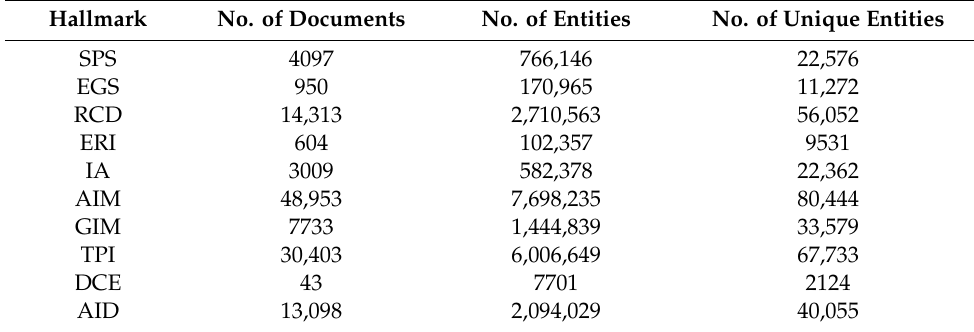
Table 7. The statistics of the weak-labeled documents (lung